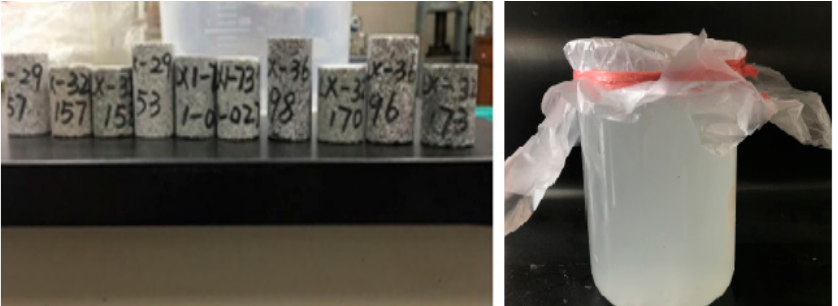
Figure 1. Key experimental equipment.